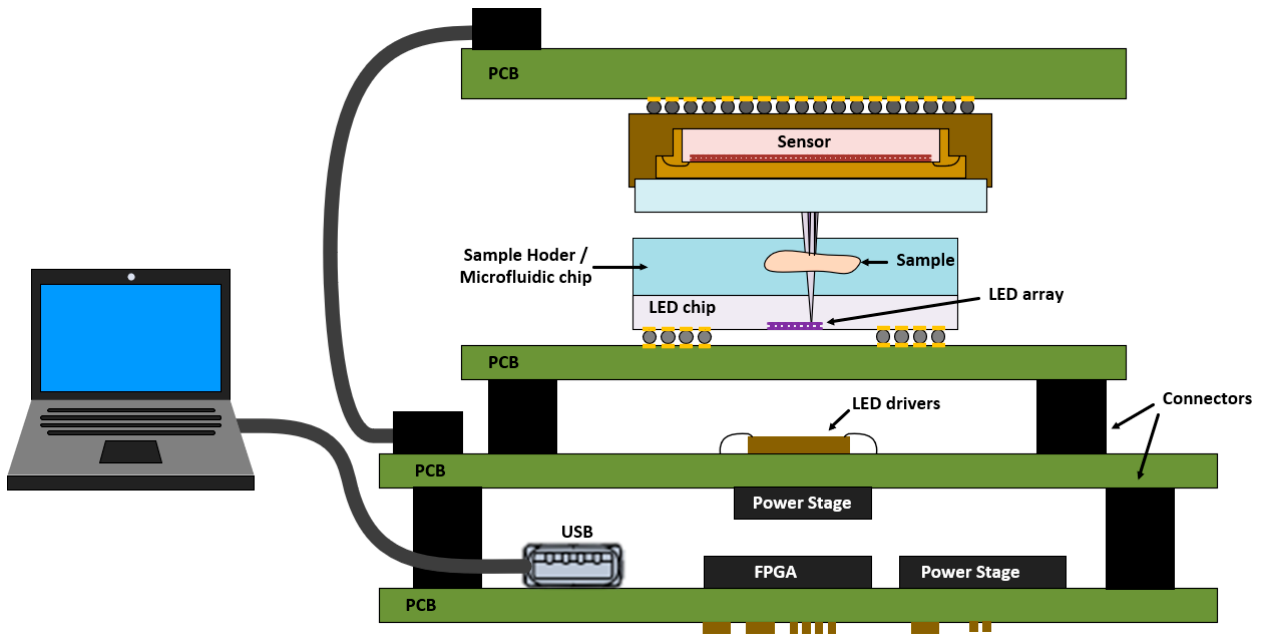
Figure 2. Scheme diagram of the basic stack-up structure used in all the microscopes.